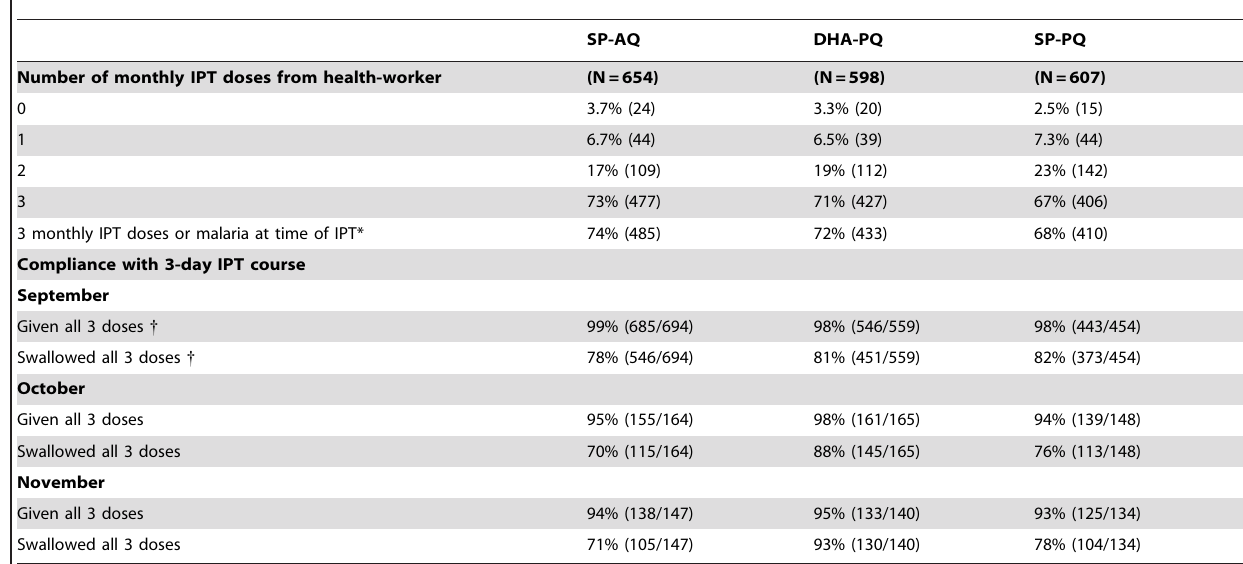
Table 2. Compliance with monthly IPT schedule and adherence to 3-day regimens.